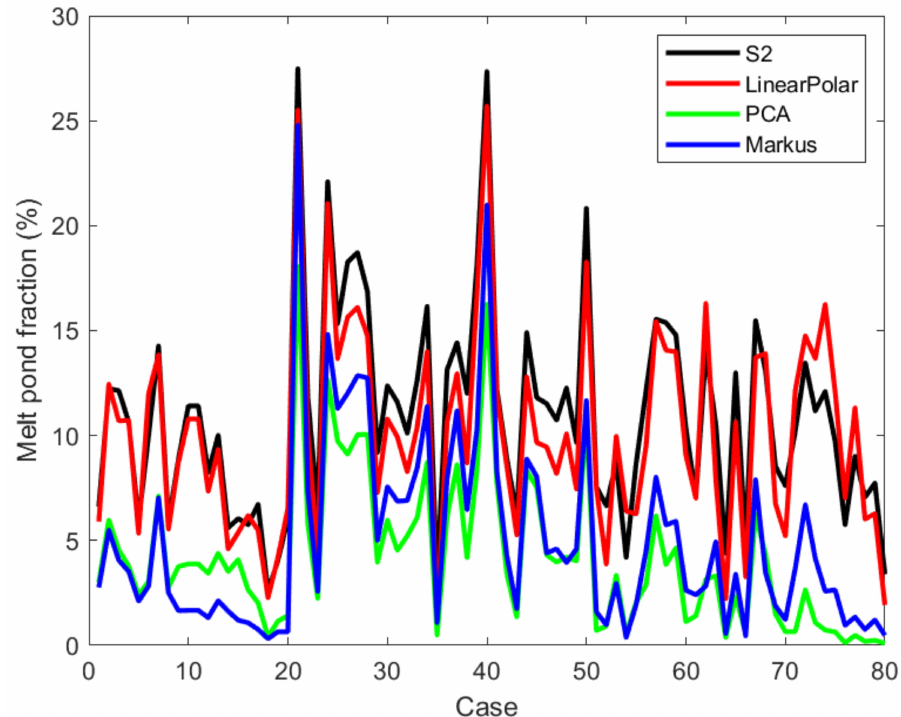
Figure 8. The MPF retrieval results using LinearPolar (red), PCA (green), s and Markus (blue)